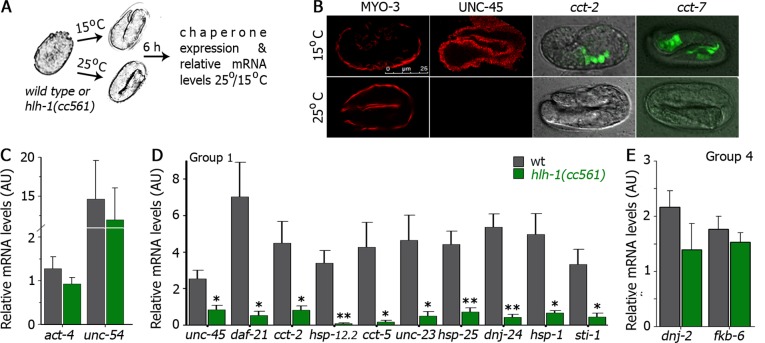
Reduced HLH-1 levels result in a decline in chaperone expression.(A) Schematic representation of the experimental setup. Wild type or hlh-1(cc561) embryos were grown at 15 or 25°C for 6 h and chaperone expression was examined. (B) Representative images (>90%) of the expression pattern of the indicated chaperones in hlh-1(cc561) embryos grown at 15 or 25°C. Scale bar is 25 μm. (C-E) Relative mRNA levels (25/15°C) of wild type (gray) or hlh-1(cc561) (green) embryos (normalized to T07A9.15). Data are presented as means ± SEM of 5 independent experiments.